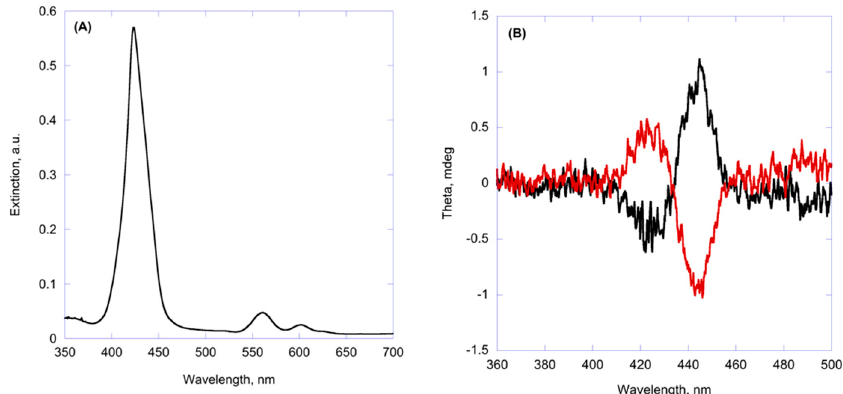
Figure 2. ( A ) UV-Vis of ZnpCTPP(-) 5.0 μ M aggregates (EtOH/H 2 O 25:75 v : v ; 298 K) in the presence of ( S )-1-phenylethanamine 5.0 × 10 − 4 M. The spectrum obtained in the presence of ( R )-1-phenylethanamine is virtually superimposable. ( B ) CD spectra of ZnpCTPP(-) 5.0 μ M (EtOH/H 2 O 25:75 v : v ; 298 K) in the presence of ( S )-1-phenylethanamine 5.0 × 10 − 4 M (black trace); ( R )-1-phenylethanamine 5.0 × 10 − 4 M (red trace).